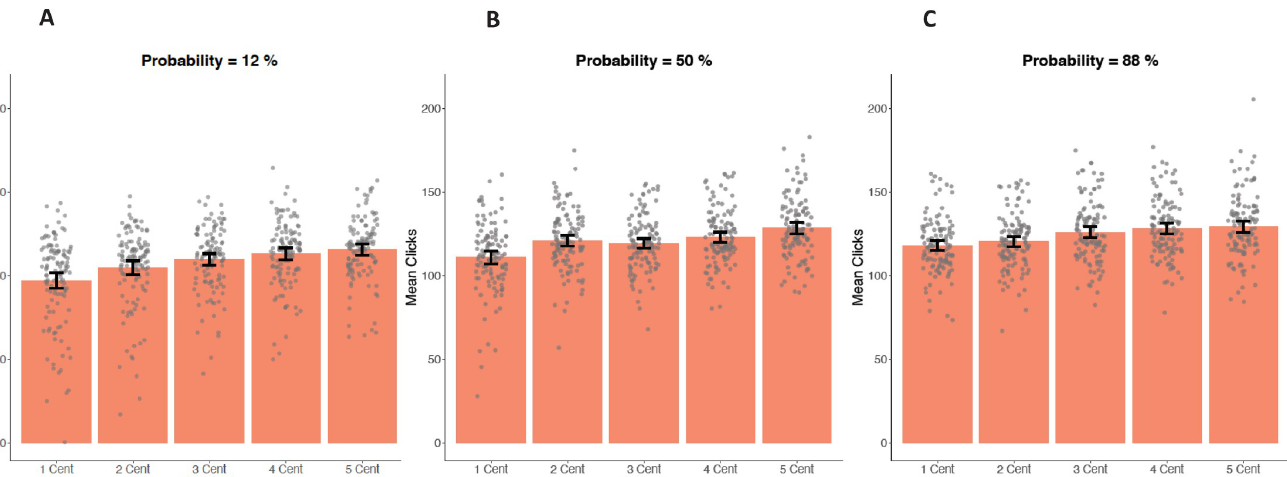
PLOS ONE | https://doi.org/10.1371/journal.pone.0262902 January 28,